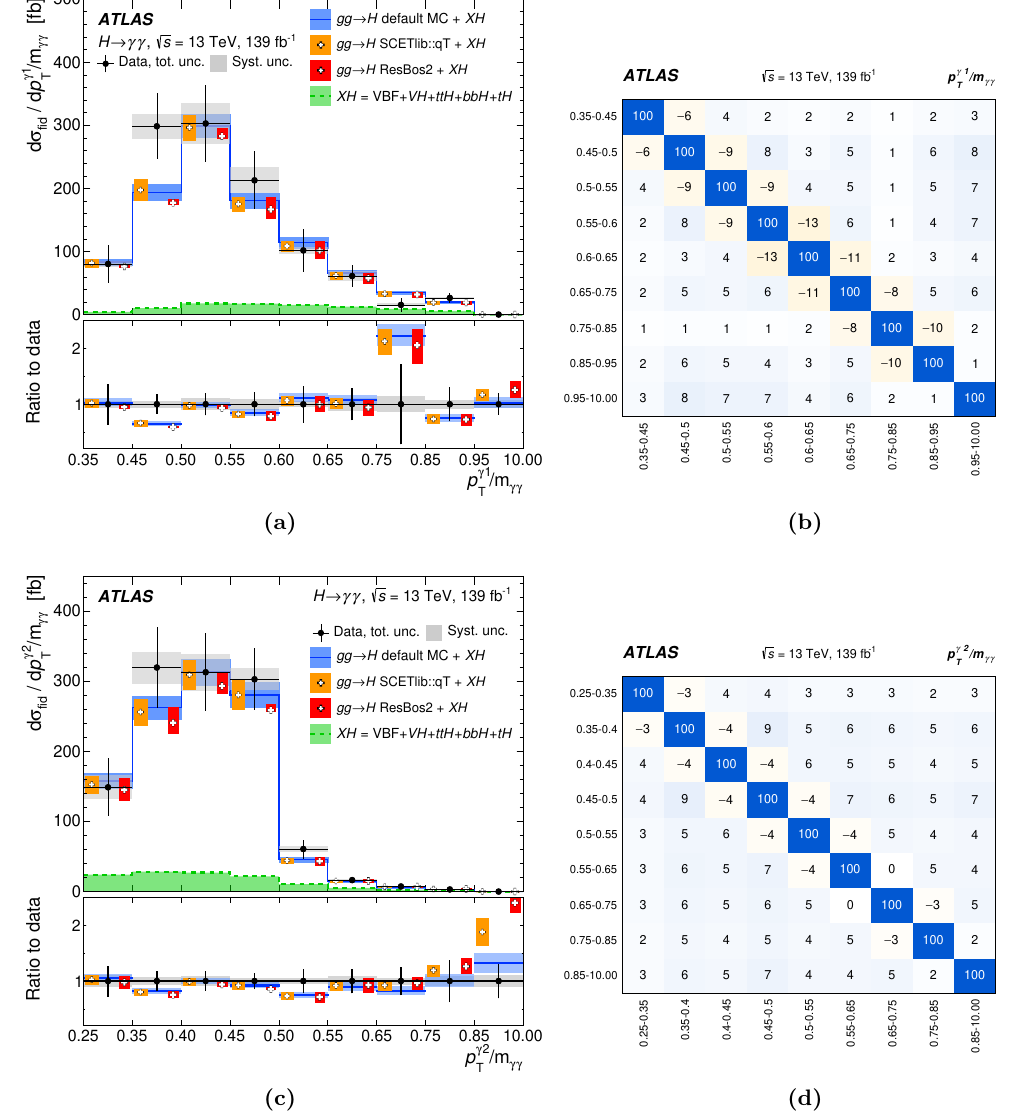
Figure 25. Particle-level fiducial differential cross-sections times branching ratio for the photon variables (a) p γ 1 /m γγ and (c) p γ 2 /m γγ together with the corresponding correlation matrices ((b) T T and